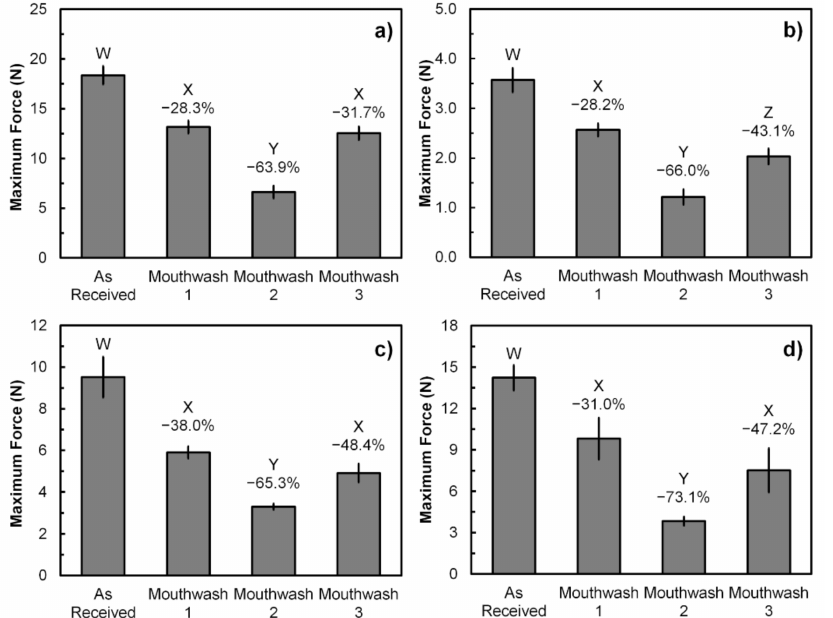
Figure 3. The maximum force obtained from universal tensile testing of the as-received and mouthwash-rinsed samples: ( a ) Brand A; ( b ) Brand B; ( c ) Brand C; and ( d ) Brand D. Error bars represent SD ( n = 3). Different W, X, Y, and Z letters between the sample groups represent p < 0.05 (One-way ANOVA with Tukey’s HSD pairwise comparison) when compared against each other. Reduction percentages are relative to the As-Received samples.